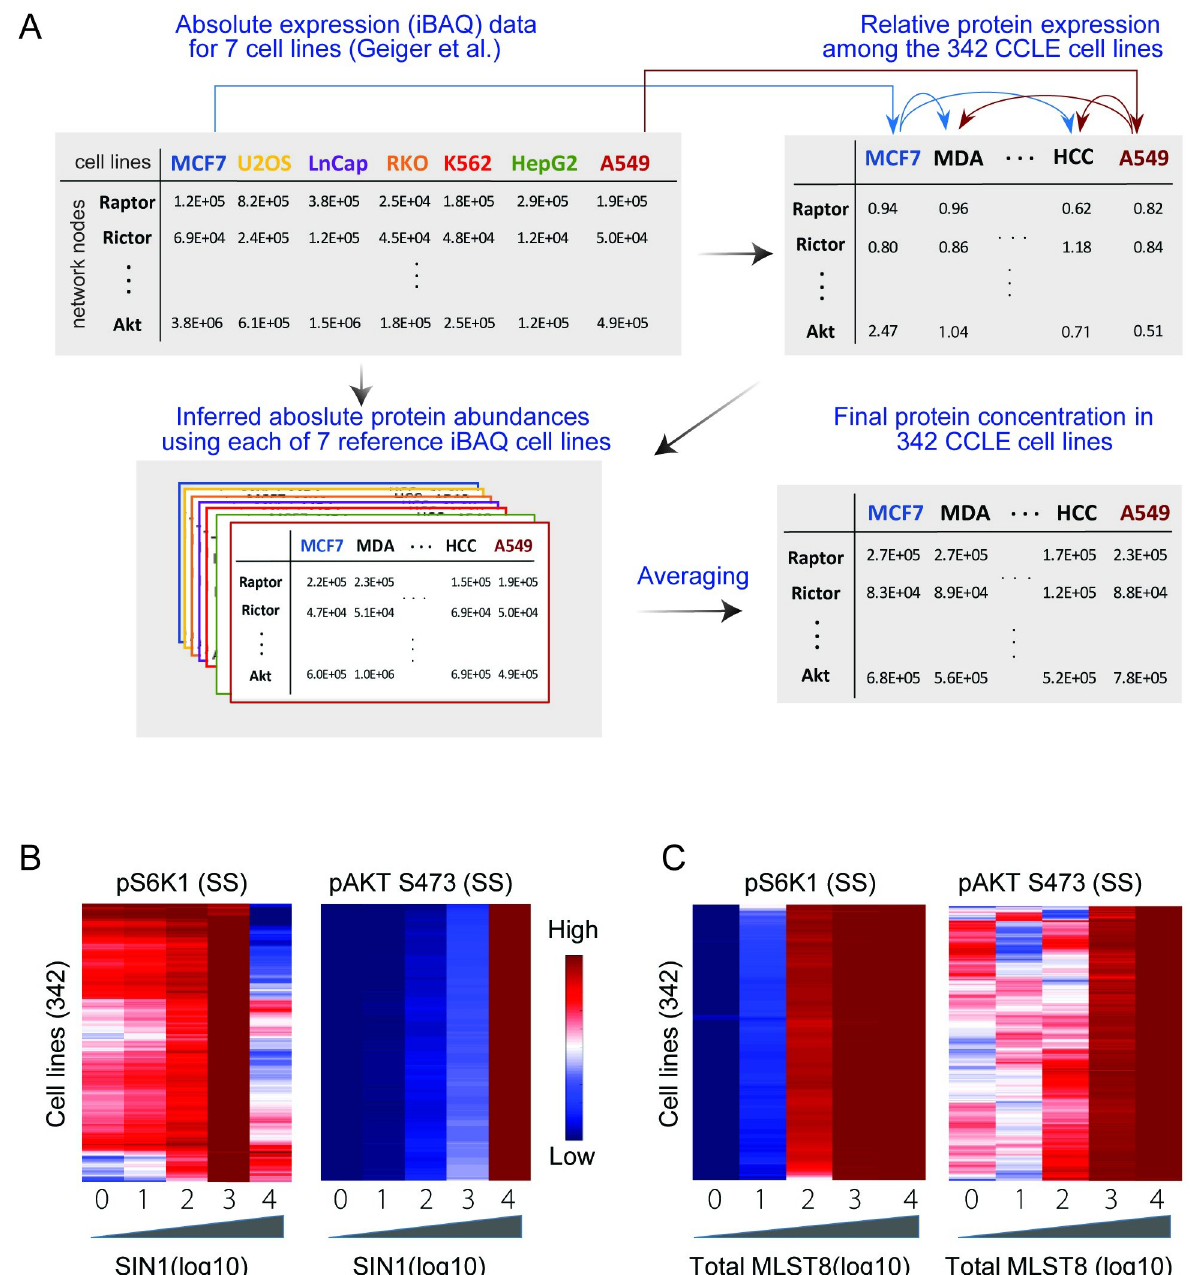
Fig 5. The mTORC1-SIN1 biphasic dependency is robust under diverse cellular contexts. (A) Pipeline for inference of absolute protein levels in 342 CCLE cell lines by combining CCLE relative expression and Geiger iBAQ-based absolute expression data. (B) Heatmap representing dose- response simulation of pS6K1 in response to increasing SIN1 expression, showing the SIN1-mTORC1 dependency is a robust biphasic pattern across multiple cell lines. For each line, SIN1 concentration is perturbed from 0.01 to 1000 fold of its initial value and pS6K1 is measured at the steady state (SS). (C) Heatmaps representing dose-response simulation of pS6K1 (left) and pAKT S473 (right) in response to increasing MLST8 expression in 342 cancer cell lines.